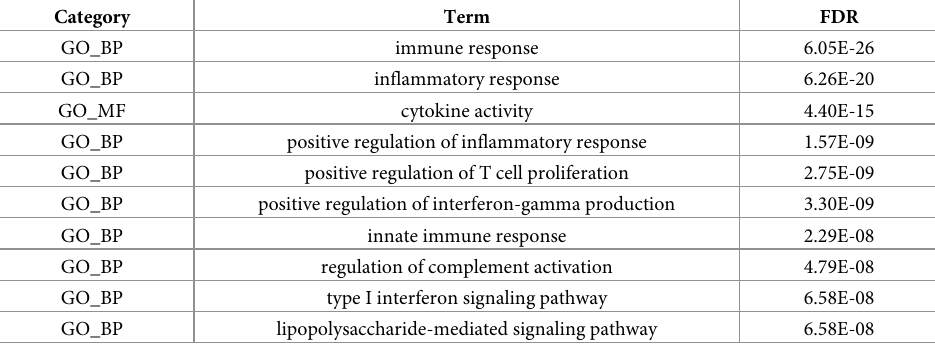
Table 1. The top 10 significant GO terms of gene set analysis using associated genes.